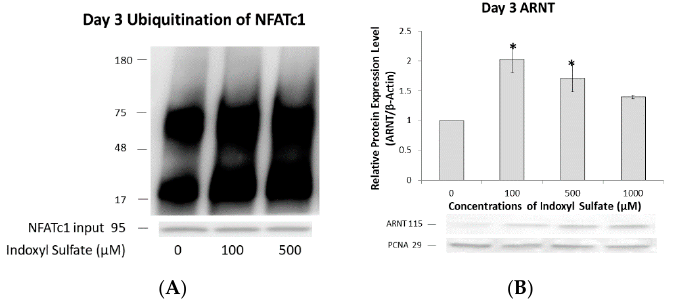
Figure 5. IS dose-dependent NFATc1 ubiquitination and ARNT expression. Raw 264.7 cells with 50 ng/mL of sRANKL were cultured in IS at 0, 100, 500, and 1000 µM for 3 days. ( A ) NFATc1 ubiquitination on Day 3 depended on the IS level. NFATc1 ubiquitination at lower IS levels (100 µM) is low, compared to that at higher IS levels (1000 µM). Immunoprecipitated NFATc1 is shown as an input. A representative example of three independent experiments is shown. ( B ) ARNT expression on Day 3 depended on the IS level. Western blot analysis showed that low IS levels (100 µM) increased nuclear ARNT expression, while high levels (>500 µM) inhibited it. Error bars represent mean ± SD ( n = 3). * P < 0.05 compared to the control group.